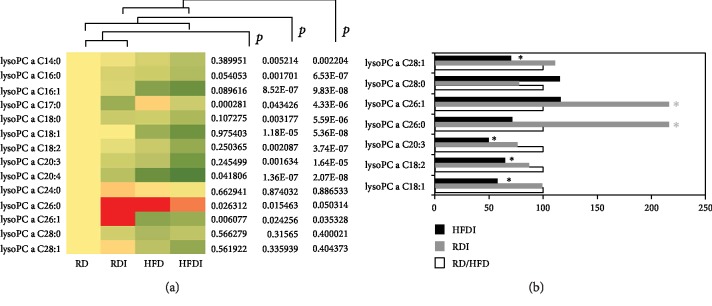
Comparison of 14 lysophosphatidylcholines profiling between T. cruzi-infected and uninfected mice fed on different diets at 150 DPI. (a) Heat map representing the serum levels of various lysophosphatidylcholines during chronic infection in mice fed on either a RD or a HFD compared to uninfected RD mice at 150 DPI. Each row represents data for a specific metabolite, and each column represents the RD-fed uninfected (RD), RD-fed infected (RDI), HFD-fed uninfected (HFD), or HFD-fed infected (HFDI) mouse group. Different colors correspond to the different intensity level of metabolites (red > the control RD group and green < the control RD group). Statistically significant differences were tested using Student's t-test, and the corrected p values (q-value) are presented next to the heat map. Red, yellow, and green rectangles indicate high, moderate, and low expressions, respectively. (b) The percentage changes in the levels of LPC metabolites in infected mice compared to the respective diet-fed (RD and HFD) uninfected mice represented by a bar graph (∗significant change).